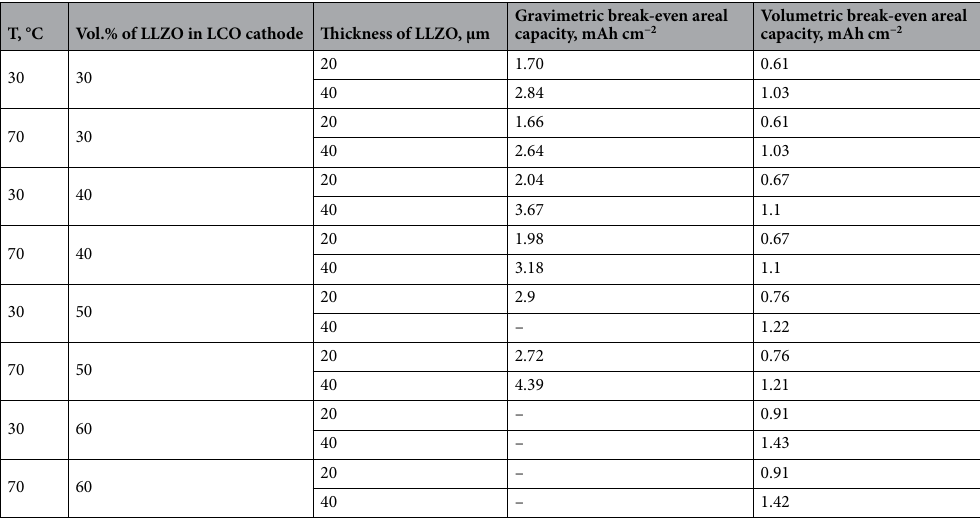
Table 1. Recommended areal capacities of LLZO–LCO cathode at given LLZO thickness and vol. % of LLZO in LCO solid-state cathode. Sign "–" means that at given temperature, LLZO thickness and LLZO content in the cathode, the Li-garnet SSB possess lower energy density values than the state-of-the-art value of 180 Wh kg −1 at a power density of 200 W kg −1 .